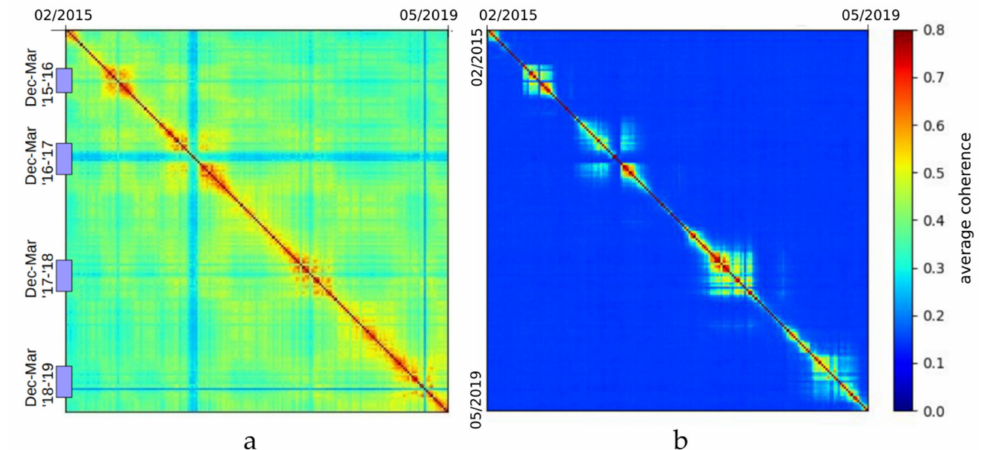
Figure 3. Interferometric coherence matrices of burst ID 95_1_21244 (February 2015—May 2019) over ( a ) urban area and ( b ) agricultural